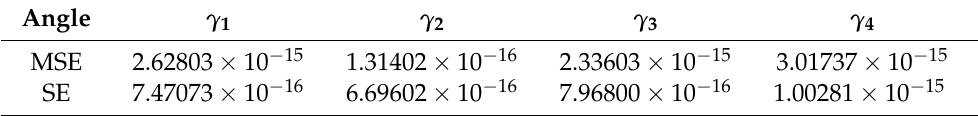
Table 13. Mean Squared Error (MSE) and Standard Error (SE) of inverse kinematics—Second Case.